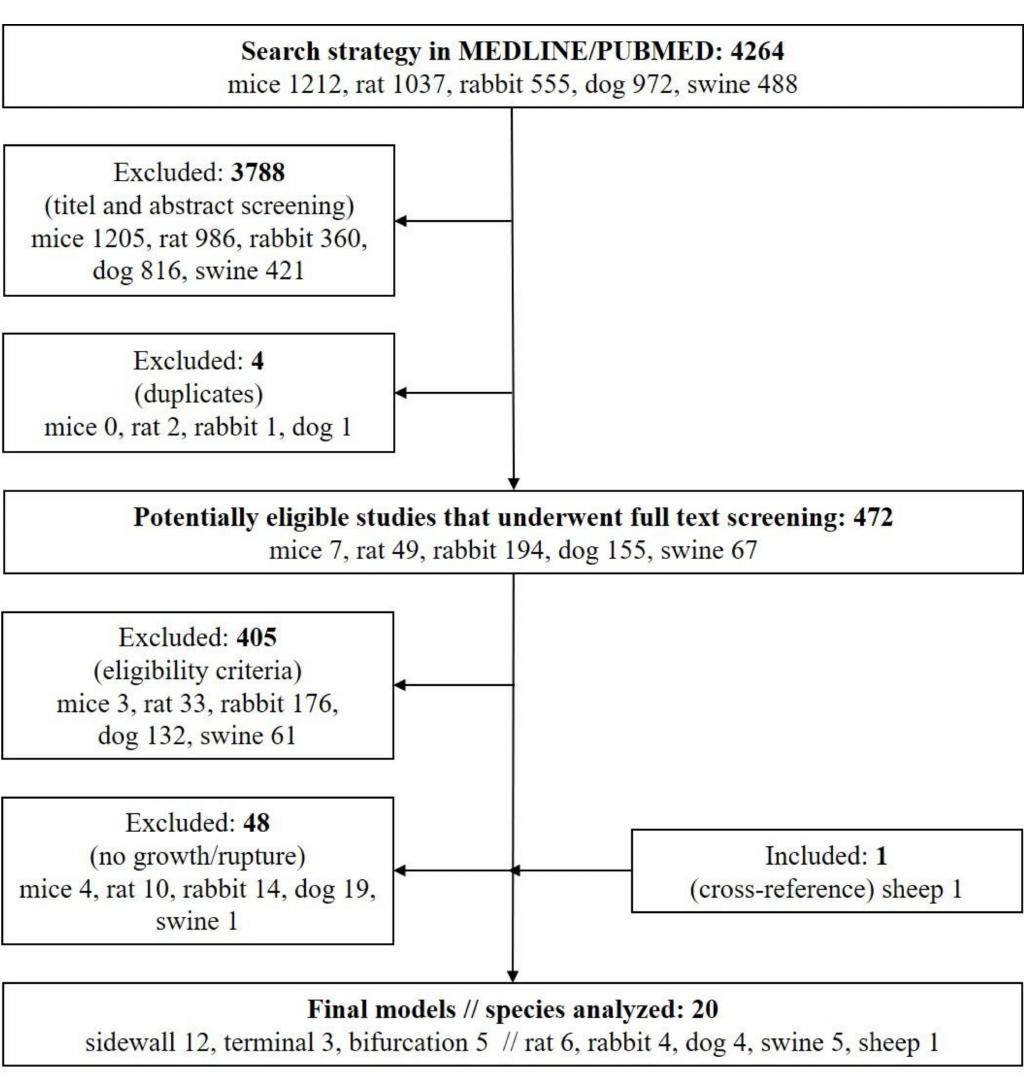
Figure 1. PRISMA flow chart for study